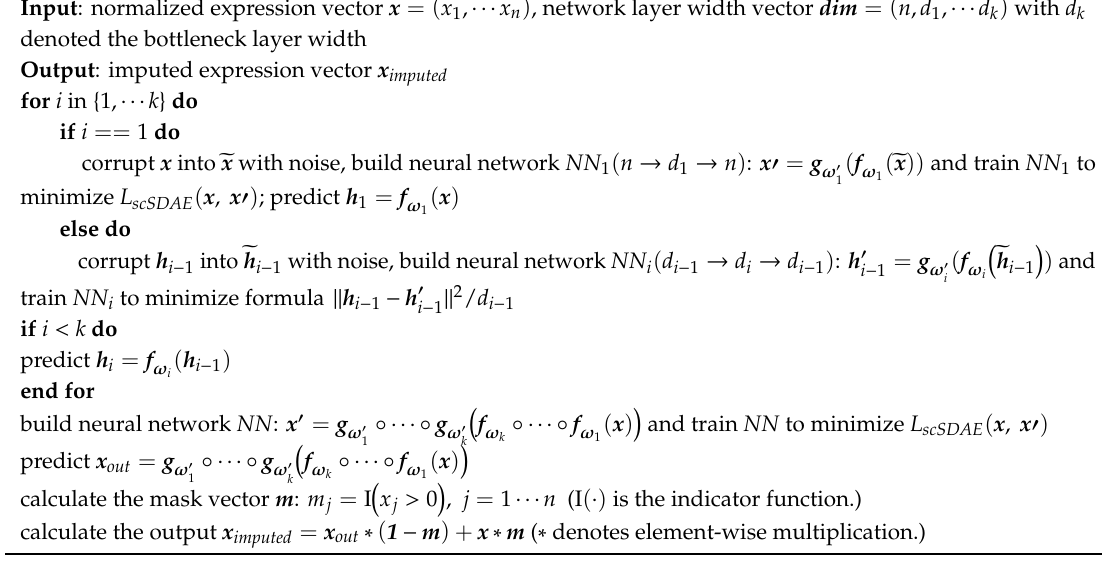
Figure 1. Schematic of scSDAE to impute scRNA ‐ seq data. The figure shows the stacked autoencoders with a mixture of reconstruction loss on non-zero values and sparse penalty on zero values. The shades of the boxes represent the values. The darker the colors, the bigger the values. Additionally, white boxes represent zero values. The input is the normalized expression vector of a cell (purple boxes), and the output is of the same dimension as input (also purple boxes with less zeros). The yellow boxes depict the bottleneck layer, while blue boxes, green boxes, and orange boxes indicate the hidden layers of the stacked autoencoders. Algorithm 1. Sparsity penalized stacked denoising autoencoders for single cell RNA-seq data (scSDAE). Input : normalized expression vector x = ( x 1 , ··· x n ) , network layer width vector dim = ( n , d 1 , ··· d k ) with d